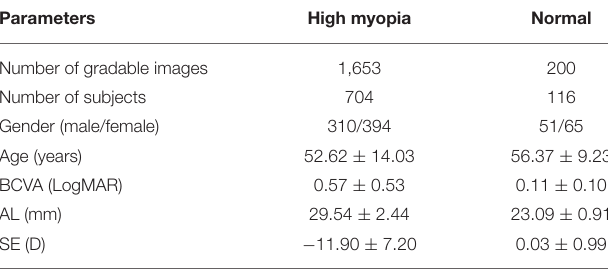
TABLE 2 | Demographic characteristics of